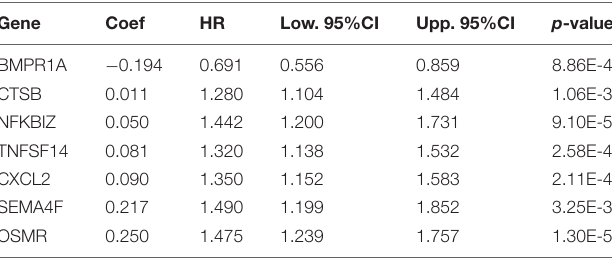
7 prognostic immune-related genes screened out by the univariate Cox regression and LASSO Cox proportional hazards